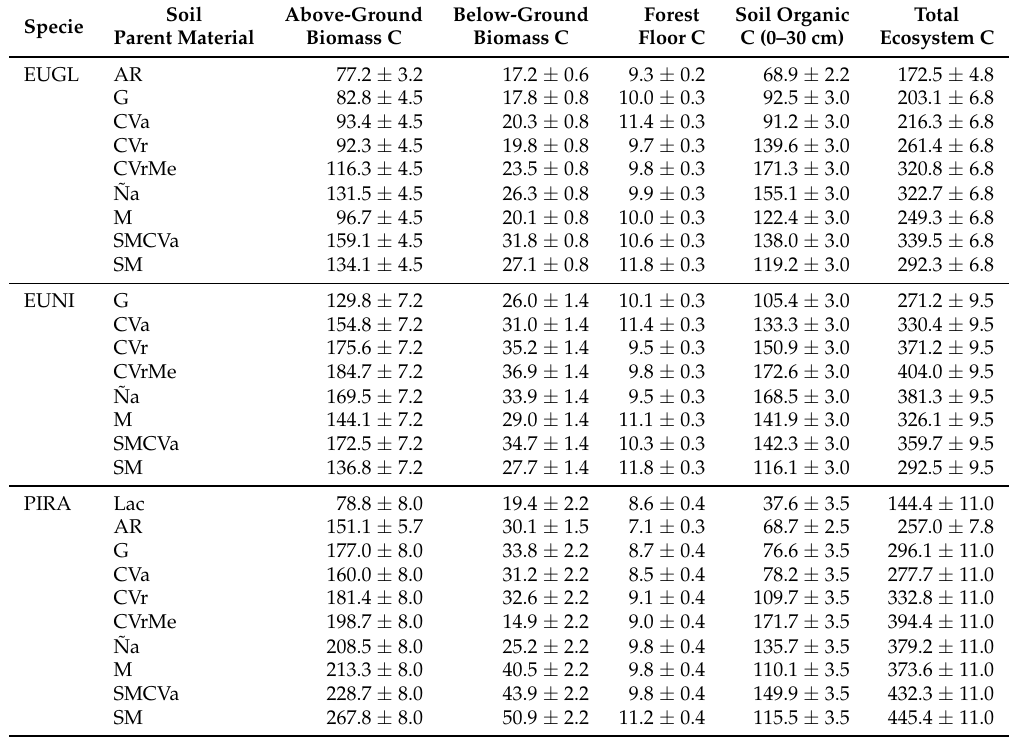
Table A6. Average ( ± standard deviation, n = 11,084) carbon (C) stocks [Mg · ha − 1 ] in each parent material for each specie at rotation age (10–14 years-old for EUGL and EUNI, 20–24 years-old for